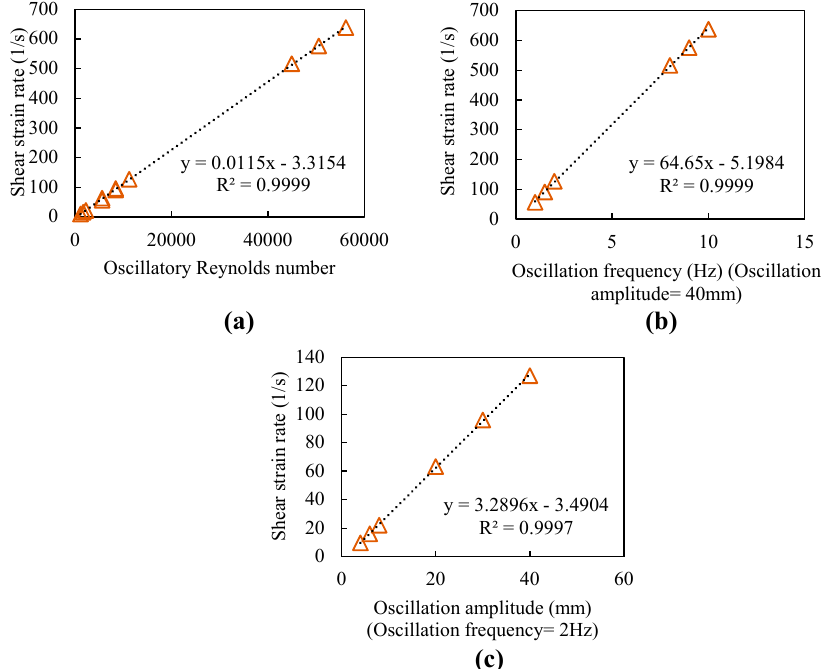
Figure 17. Shear strain rate versus ( a ) oscillatory Reynolds number, ( b ) oscillation frequency, and ( c ) oscillation amplitude.